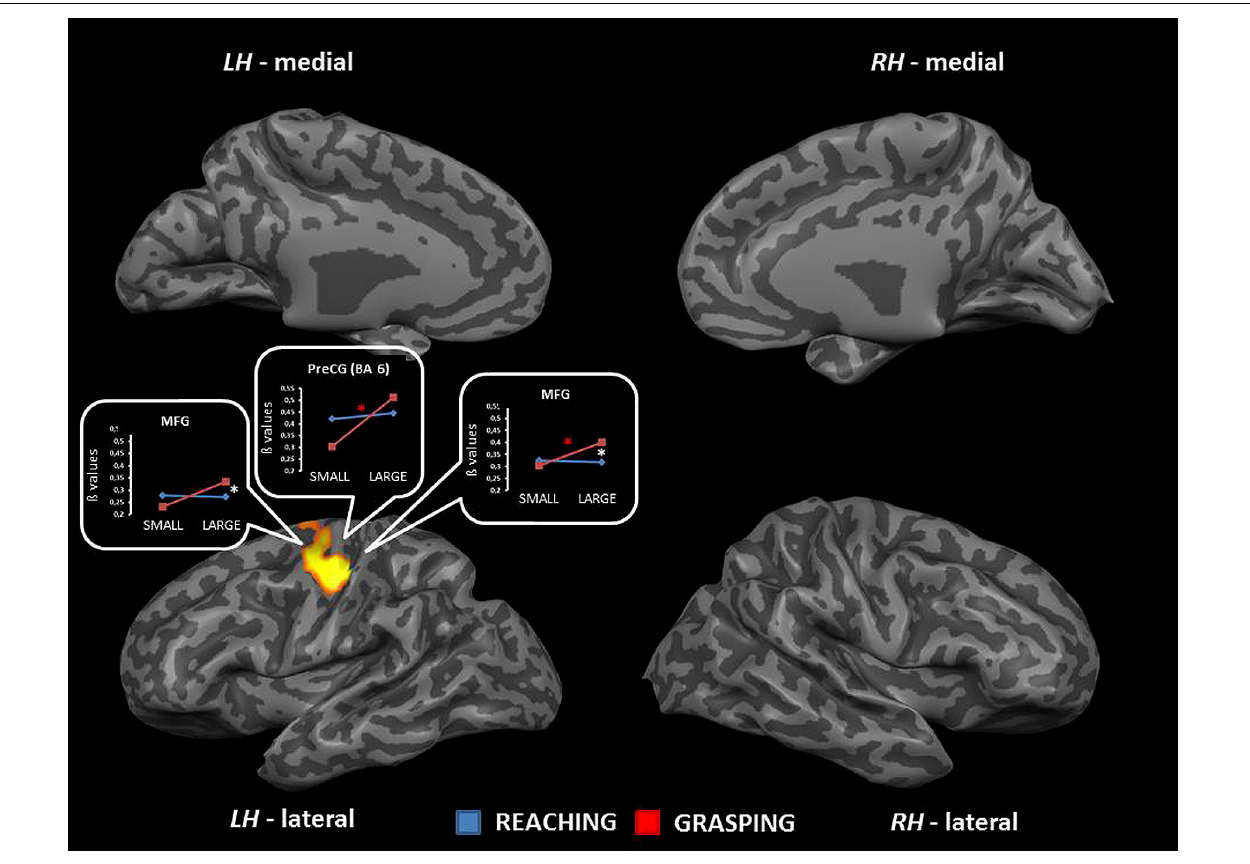
FIGURE 5 | Brain regions showing significant interaction effects between type of movement and stimulus dimension in TB 7. The p value is set to 0.001, uncorrected for multiple comparisons, cluster size k ≥ 13. White asterisks indicate significant effects for the contrast